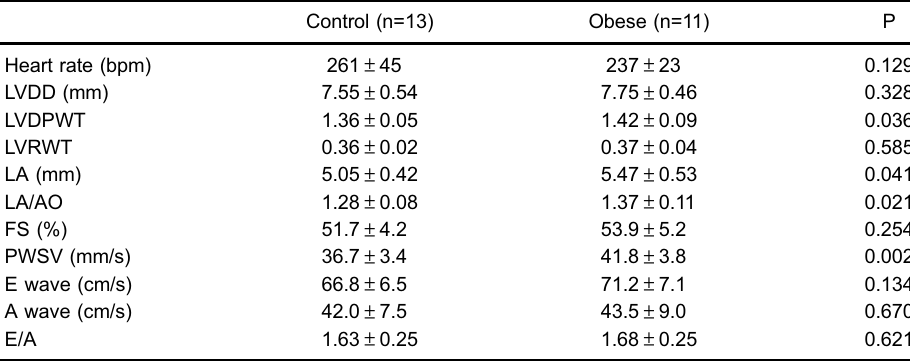
Table 3. Echocardiographic evaluation.